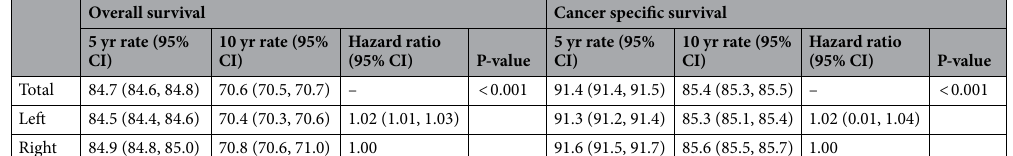
Overall survival Cancer specific